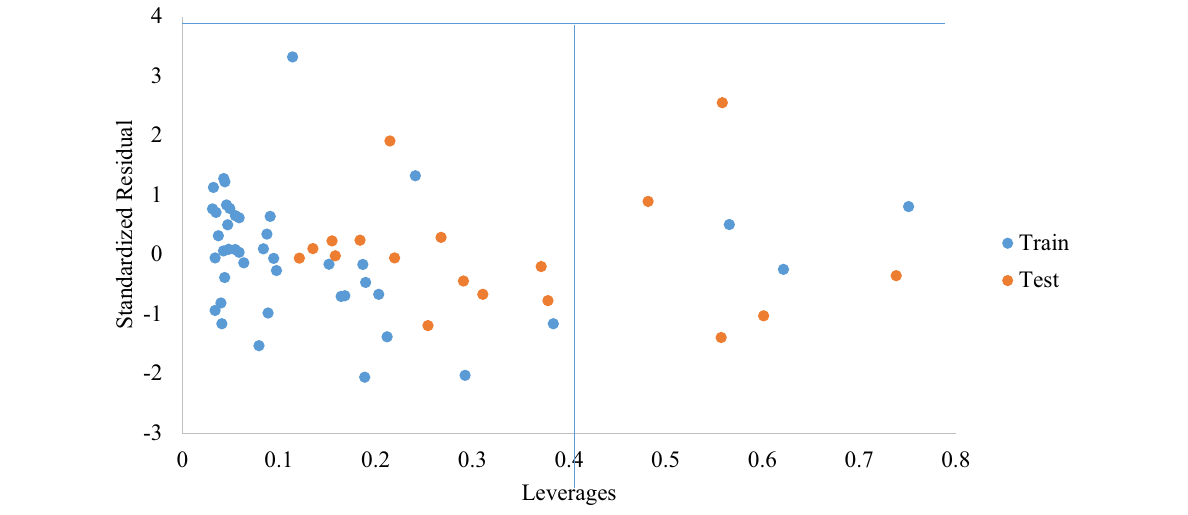
Fig. 4 Graph of standardized residual against leverages (William’s plot)